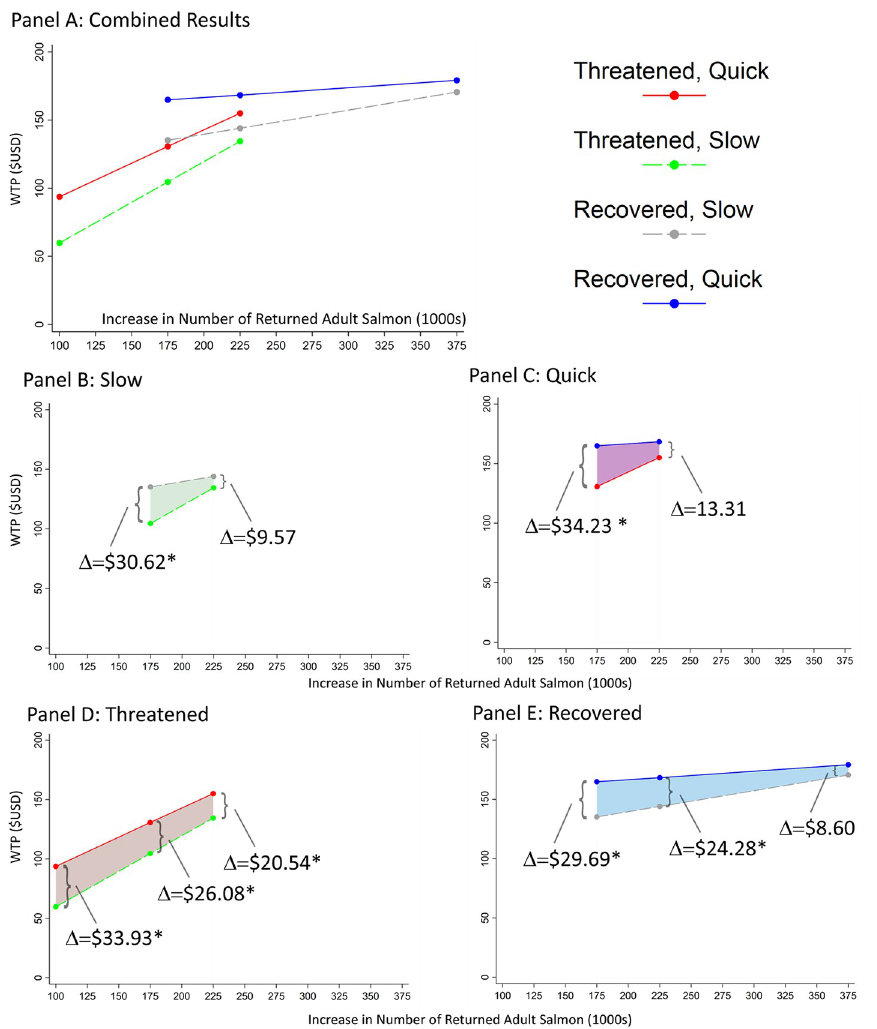
Fig 3. Estimated annual household willingness-to-pay (WTP) functions for Oregon Coast Coho salmon recovery scenarios. The y-axis in each graph depicts average annual household WTP in $USD. The x-axis in each graph represents the increase in numbers of returned adult salmon (in 50-years) from the baseline (in 1000s). A) ESA status and rate of fish return increase held fixed along each line; B) slow rate of fish return increase held fixed, Δ represents marginal change in WTP for “Recovered” ESA status; C): quick rate of fish return increase held fixed, Δ represents WTP for “Recovered” ESA status; D) ESA status of “Threatened” held fixed, Δ represents WTP for “Quick” rate of fish return increase; E) ESA status of “Recovered” held fixed, Δ represents WTP for “Quick” rate of fish return increase. � depicts p <